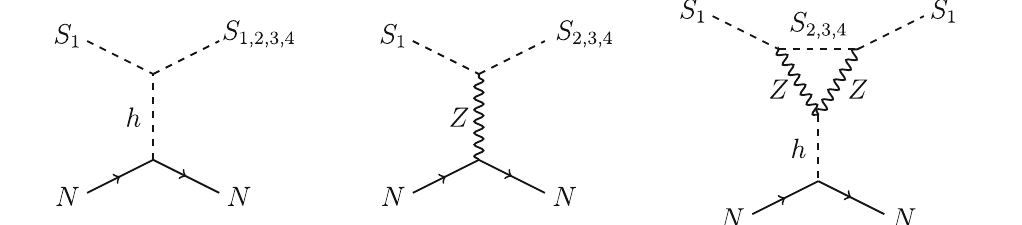
S 1 N → S j N processes do not contribute to the direct detection cross- section. The one-loop processes are represented by the rightmost dia-